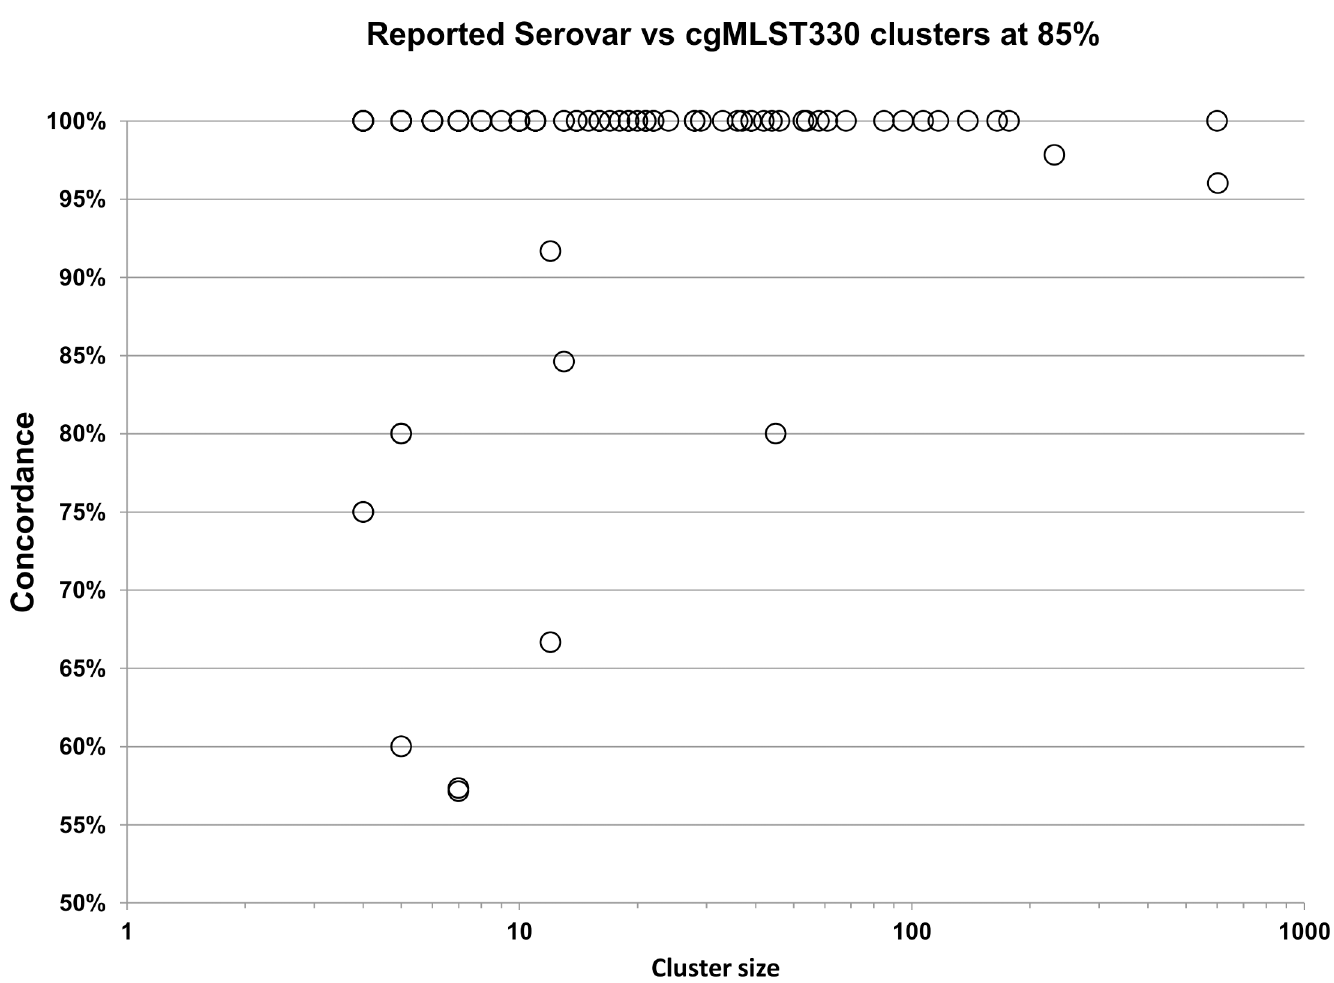
Fig 6. A high level of concordance observed between cgMLST cluster and serovar. The concordance was based on the proportion of genomes in a cgMLST cluster that belonged to the predominant predicted serovar in the group. The cgMLST clusters were defined at a similarity threshold of 85%; only clusters with four or more members are